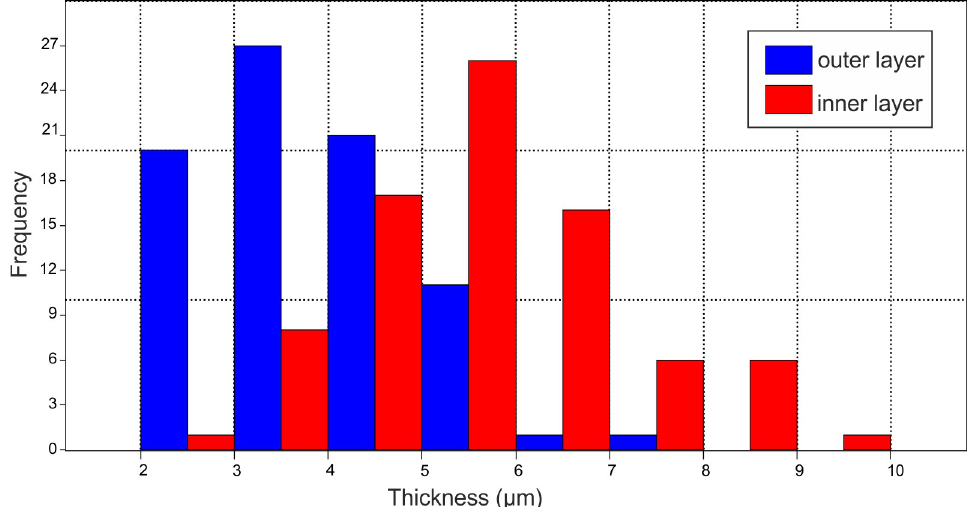
Fig 8. Thickness frequency of individual layers in the wall of the species cysts Cadosinopsis rehakovii sp. nov.